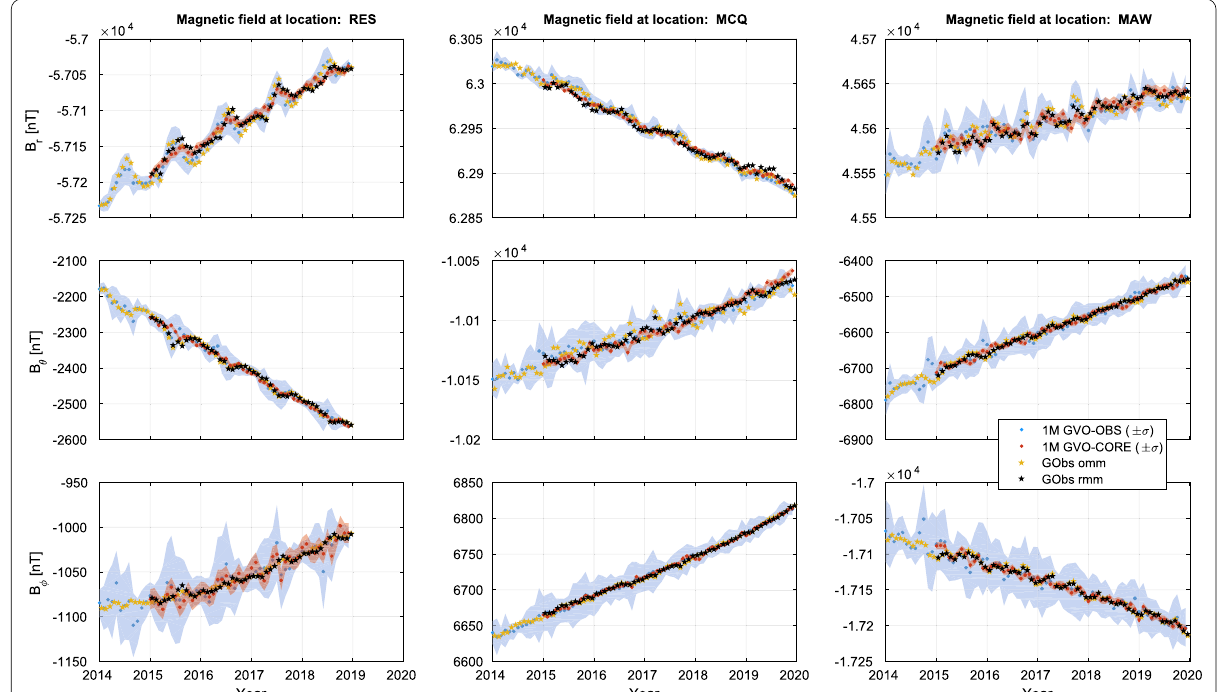
σ uncertainty envolopes, ±